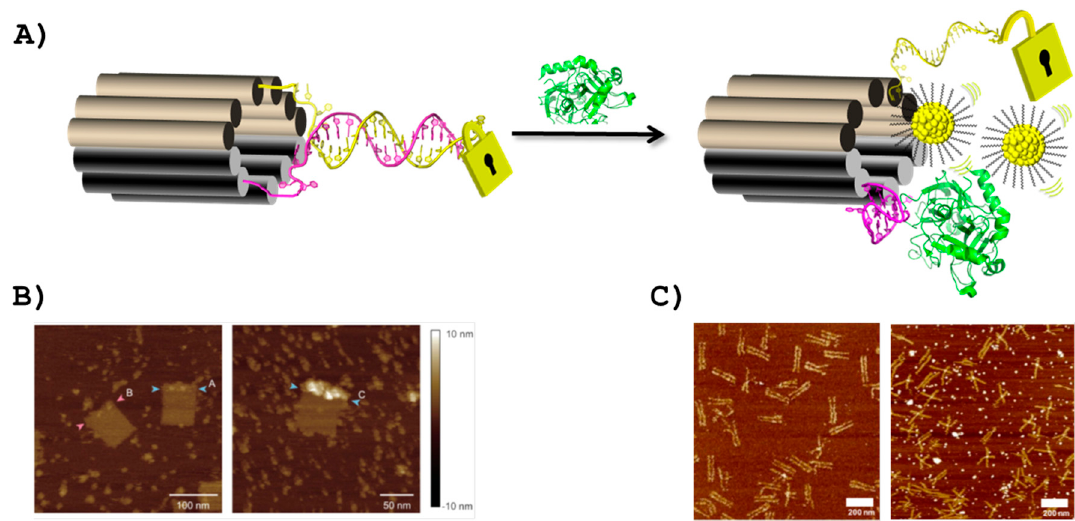
Figure 5. ( A ) Schematic representation of the aptamer-gated DNA nanorobot [151]: the aptamer (magenta) is locked in a double-stranded form by a partially complementary sequence (yellow) and both are grafted on the nanorobot. The payloads (either gold nanoparticles (shown) or antibody fragments) are constrained to remain within the DNA construct and only the recognition of intended target by the aptamer (green) will unlock the DNA nanorobot and enable the delivery of the payload; ( B ) AFM images of a DNA origami-aptamer construct in the presence of a non-target protein (hLDH; left-hand side) and presence of the target protein ( Pf LDH; right-hand side) [152]; ( C ) AFM analysis of a DNA origami equipped with a split aptamer system in the closed (left-hand side) and open (right-hand side) forms [153].